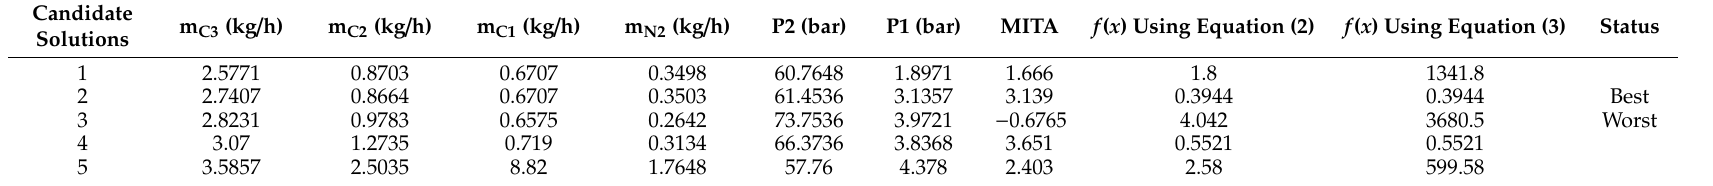
Table 7. New values of decision variables and corresponding energy during the first iteration.